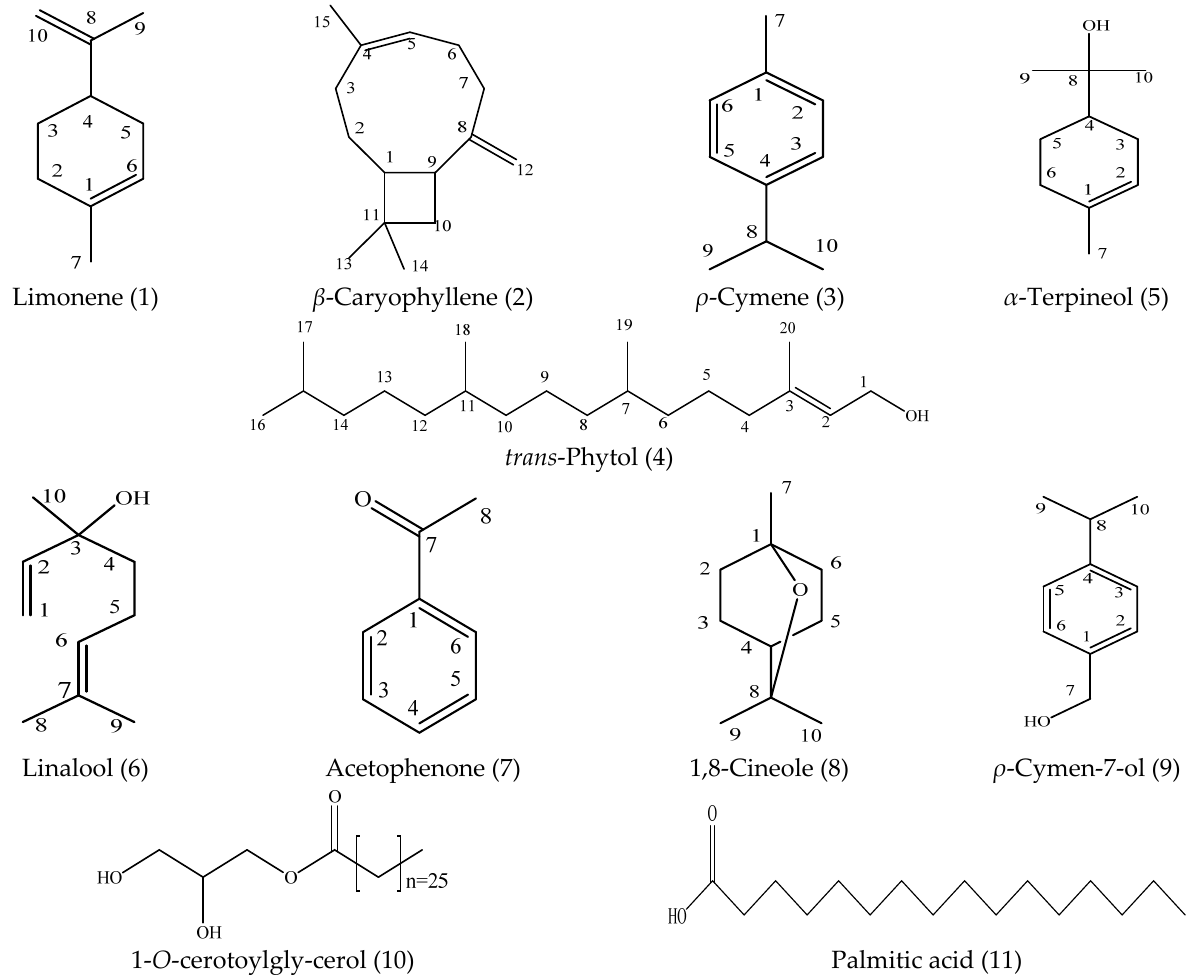
Figure 1. Compounds isolated from the essential oil of E. densa.